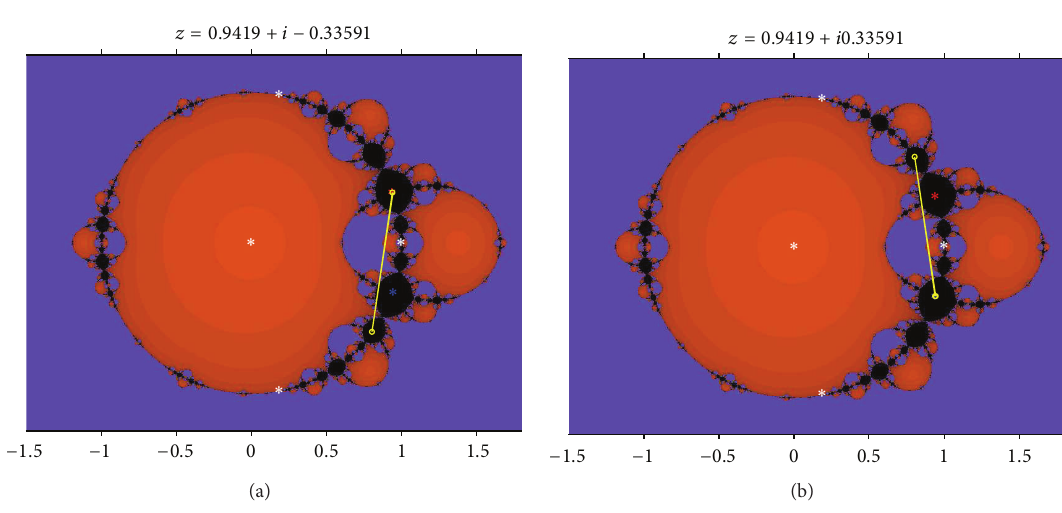
Figure 3: Two 2-cycles in the dynamical plane for 𝛼 = 1.687616